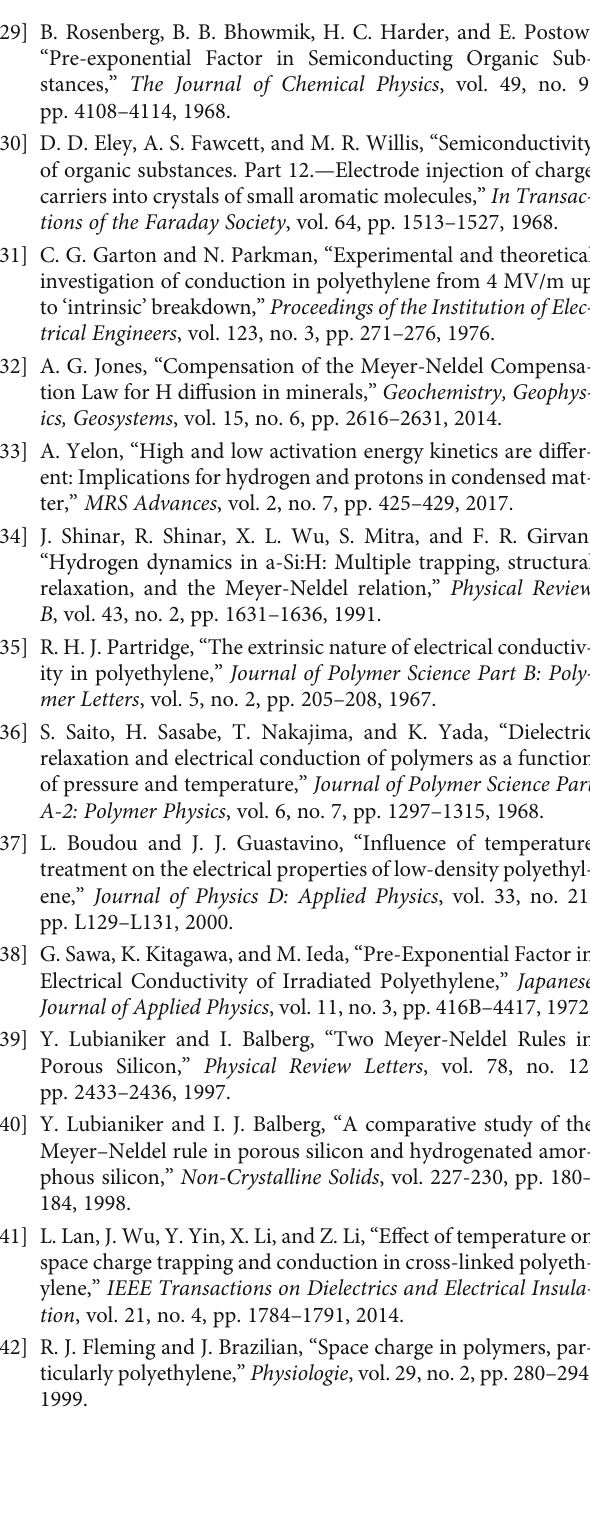
e ffi ciency improvements in the U.S , Electricity Transmission and Distribution System, Oak Ridge, TN (United States),